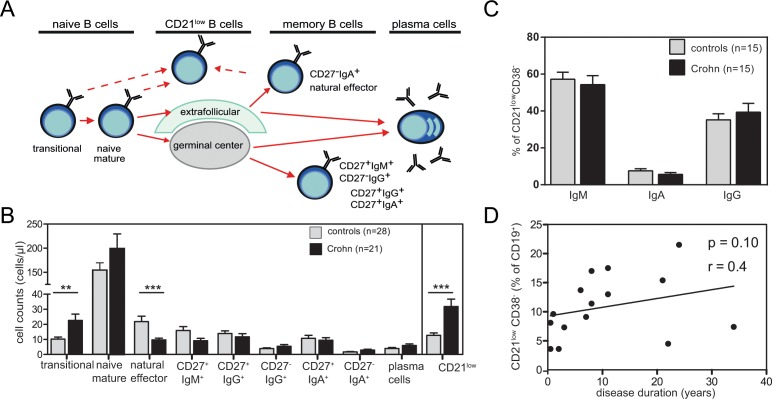
Composition of the blood B-cell compartment in patients with Crohn’s disease.A. Schematic overview of peripheral B-cell subsets. B. Average numbers of blood B cell subsets of 21 patients affected with Crohn’s disease (black bars) and 28 healthy controls (light grey bars). C. Distribution of IgM, IgA and IgG within CD21low in patients and controls D. Total CD21low B cells in relation to disease duration. Statistical analyses were performed with the Mann-Whitney test or Spearman correlation; *, P<0.05; **, P<0.01.